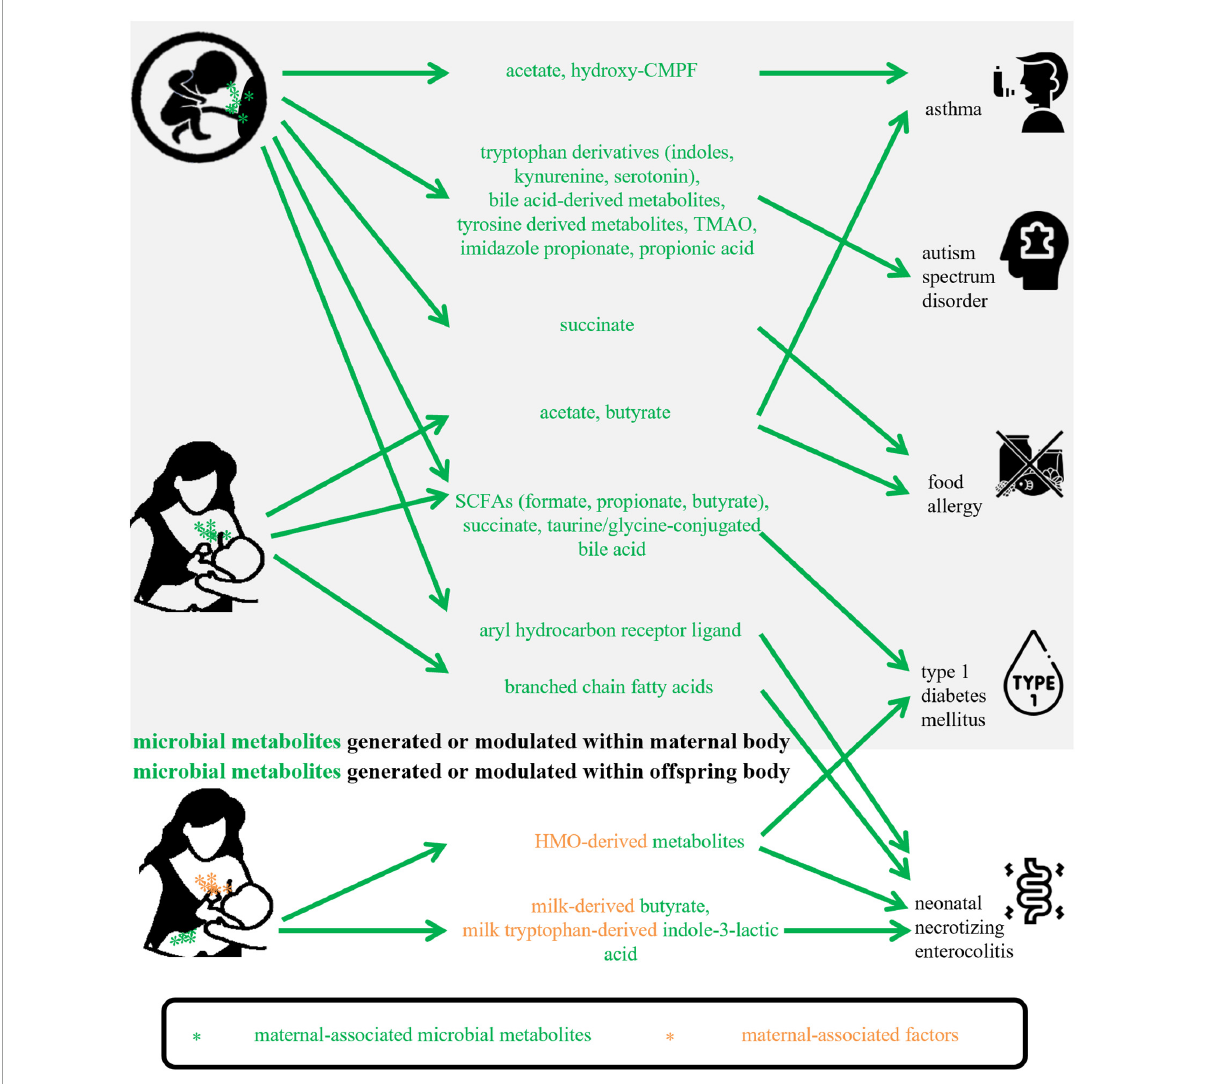
FIGURE1 Maternal-associated microbial metabolites generated within maternal body or offspring body in this review. CMPF, 3-carboxy-4-methyl- 5-propyl-2-furanpropanoic acid; TMAO, trimethylamine-N-oxide; SCFAs, short-chain fatty acids; HMO, human milk